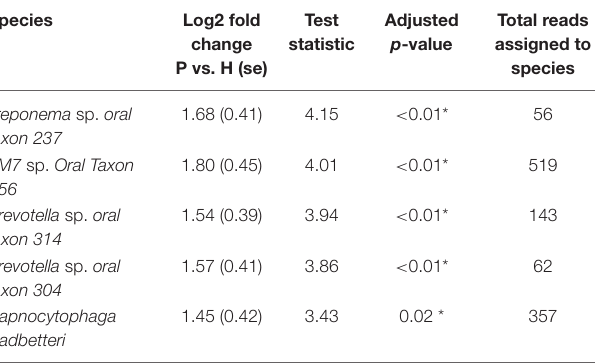
TABLE 3 | Differential abundance of significantly different species between P and H groups (DeSEQ2 test). Species Log2 fold change